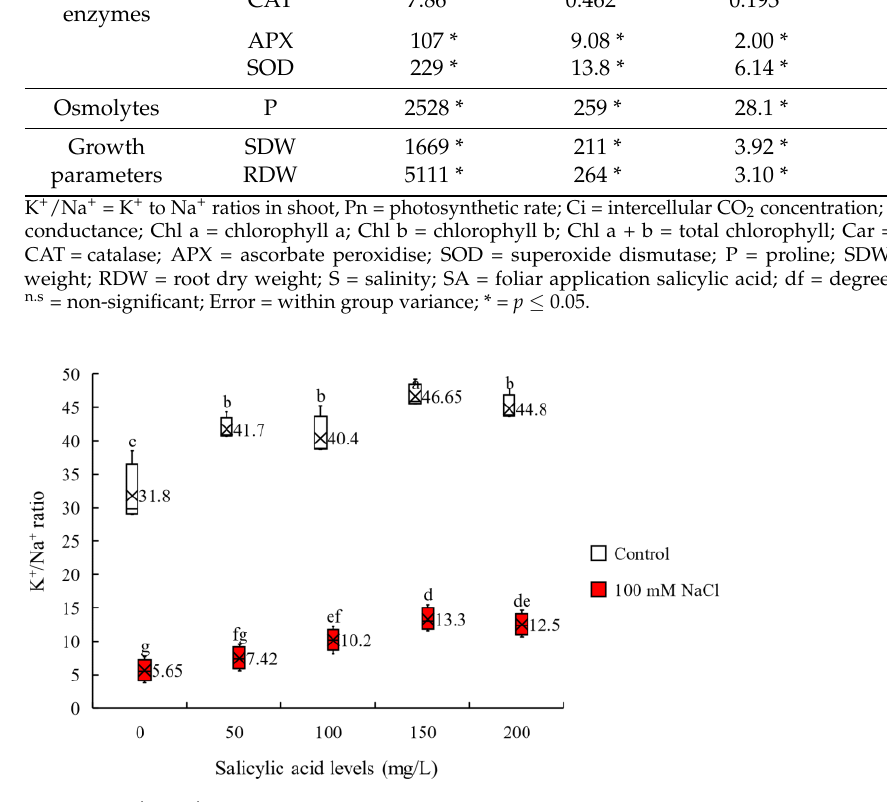
Figure 1. K + /Na + ratio of sorghum leaves for the interaction of SA treatments × salinity (100 mM NaCl) in four repetitions at milky seeds stage. Different letters indicate significant differences by HSD at p < 0.05. The data for analysis are given in Table S1. Table 1. Analysis of variances ANOVA (mean squares) for different parameters of sorghum in two levels salinity and five levels of foliar application salicylic acid in four repetitions.